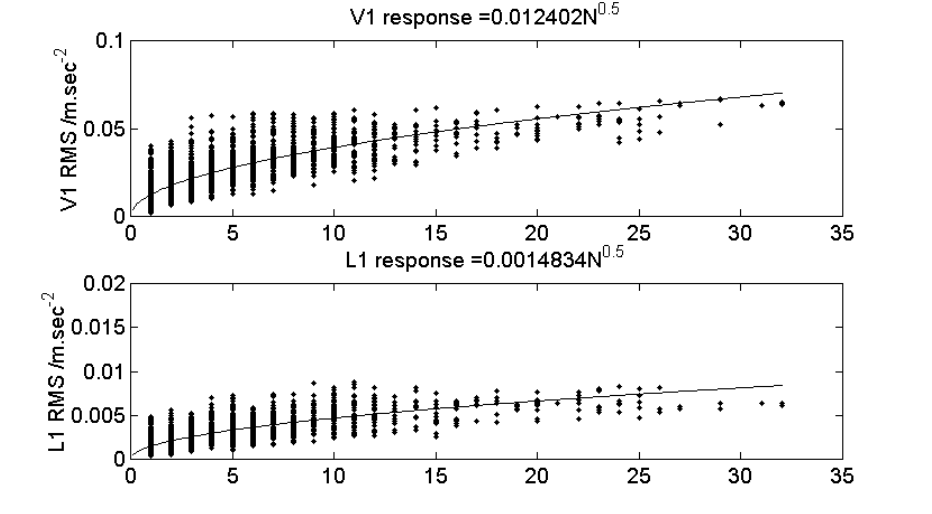
Fig. 11. Variation of RMS modal response with crowd